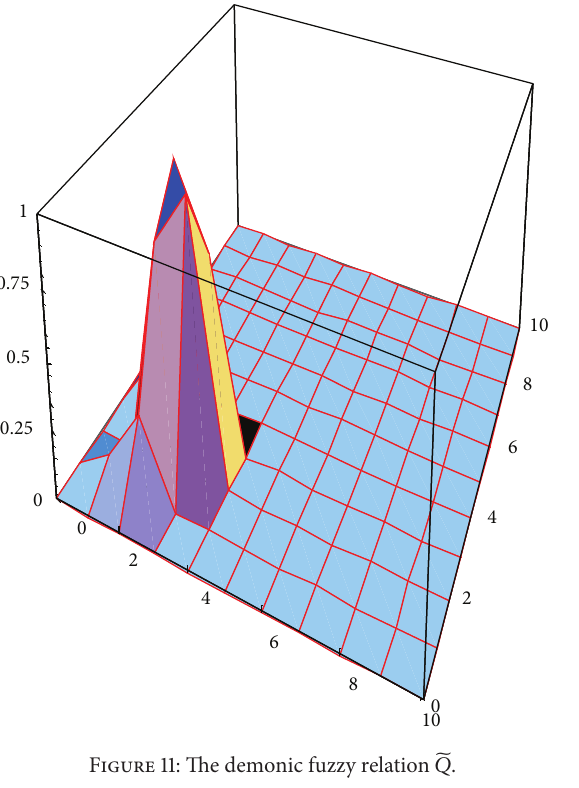
Figure 11: The demonic fuzzy relation